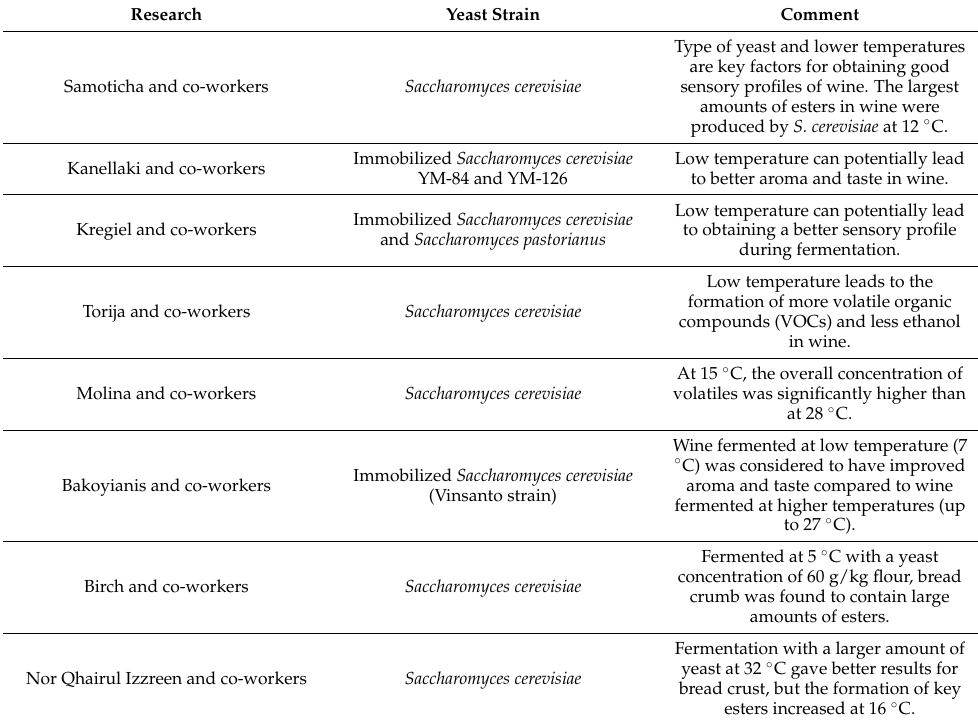
Table 6. The most common mesophilic yeasts adapted to food processing at lower